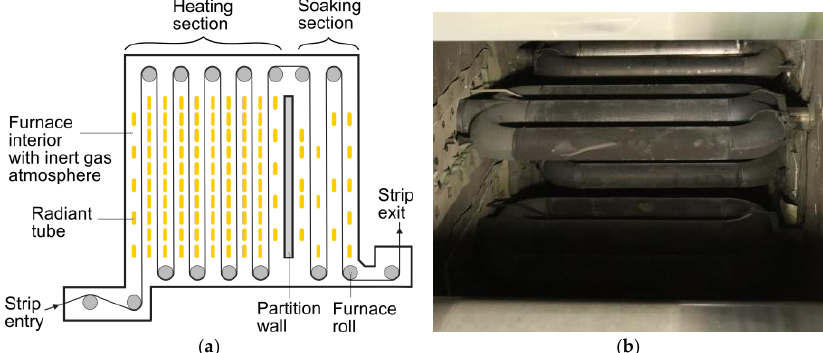
Figure 1. ( a ) Schematic of the annealing furnace of a continuous strip galvanizing line (CGL); ( b ) View from the bottom into the heating section of an annealing furnace.